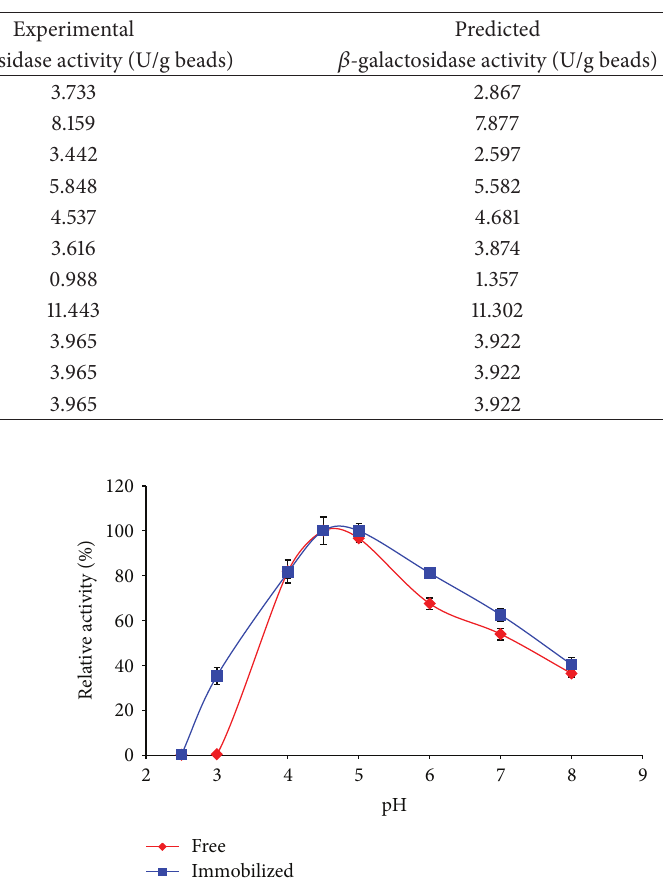
Table 2: Experimental results of CCD for 𝛽 -galactosidase activity.